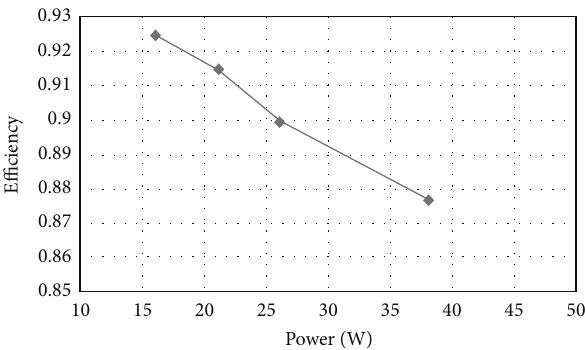
Figure 7: Experimentally measured efficiency of the proposed